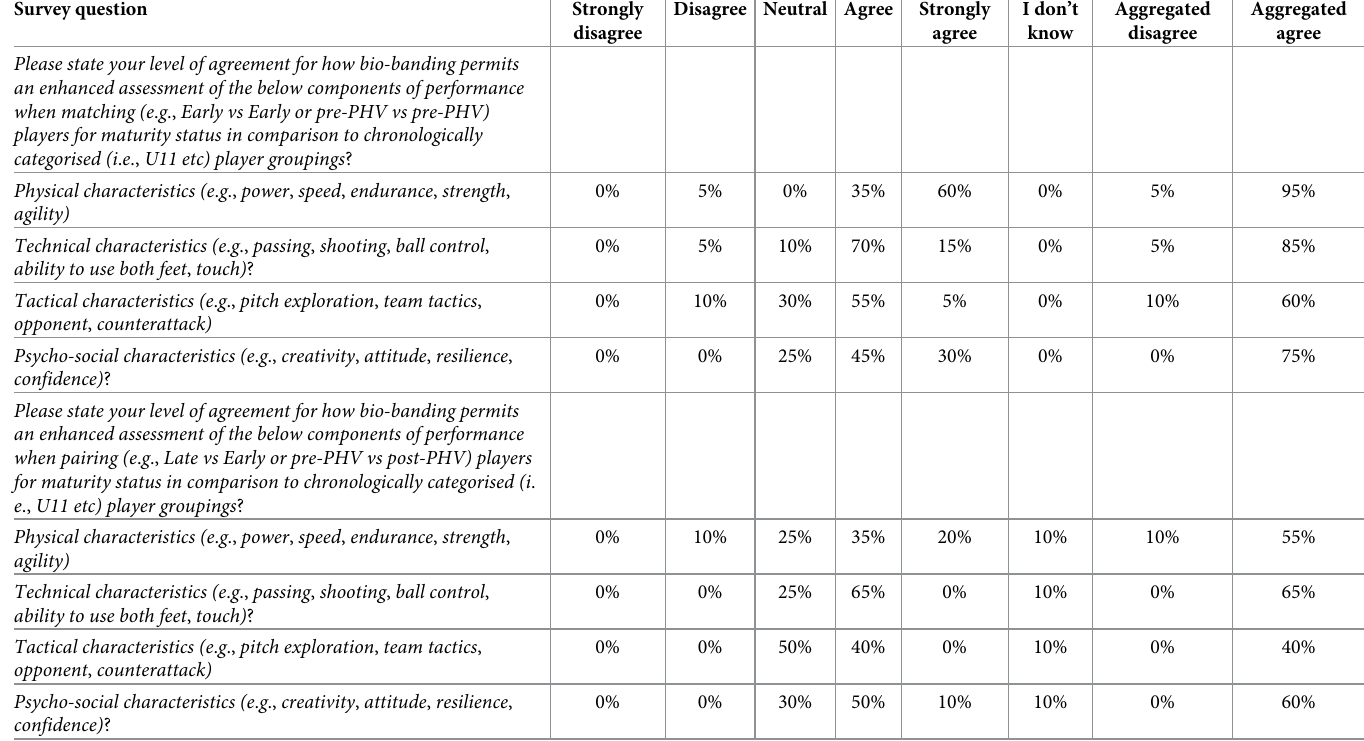
Table 2. Summary table of practitioner individual and aggregated (i.e., sum of strongly disagree and disagree; sum of strongly agree and agree) perceived agreement that matched (e.g., Early vs Early or pre-PHV vs pre-PHV) and miss-matched (e.g., Late vs Early or pre-PHV vs post-PHV) bio-banding permits enhanced assess- ment of physical, technical, tactical, and psycho-social player characteristics in comparison to chronologically categorised (i.e., U11 etc) player groupings. Survey